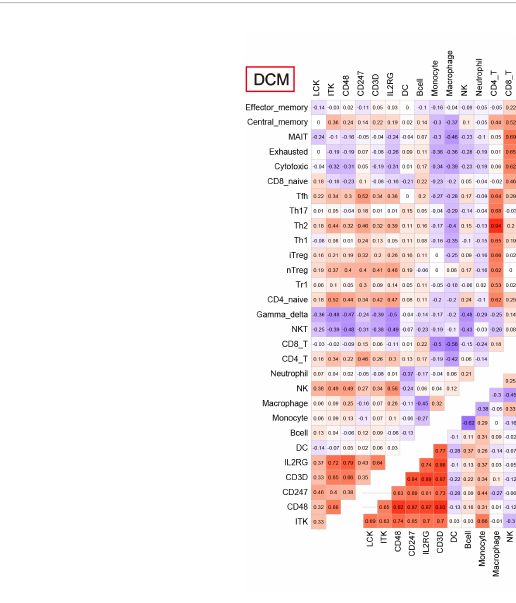
FIGURE 7 Correlation between 7 hub immune-related genes and 24 differential immune cells in DCM and